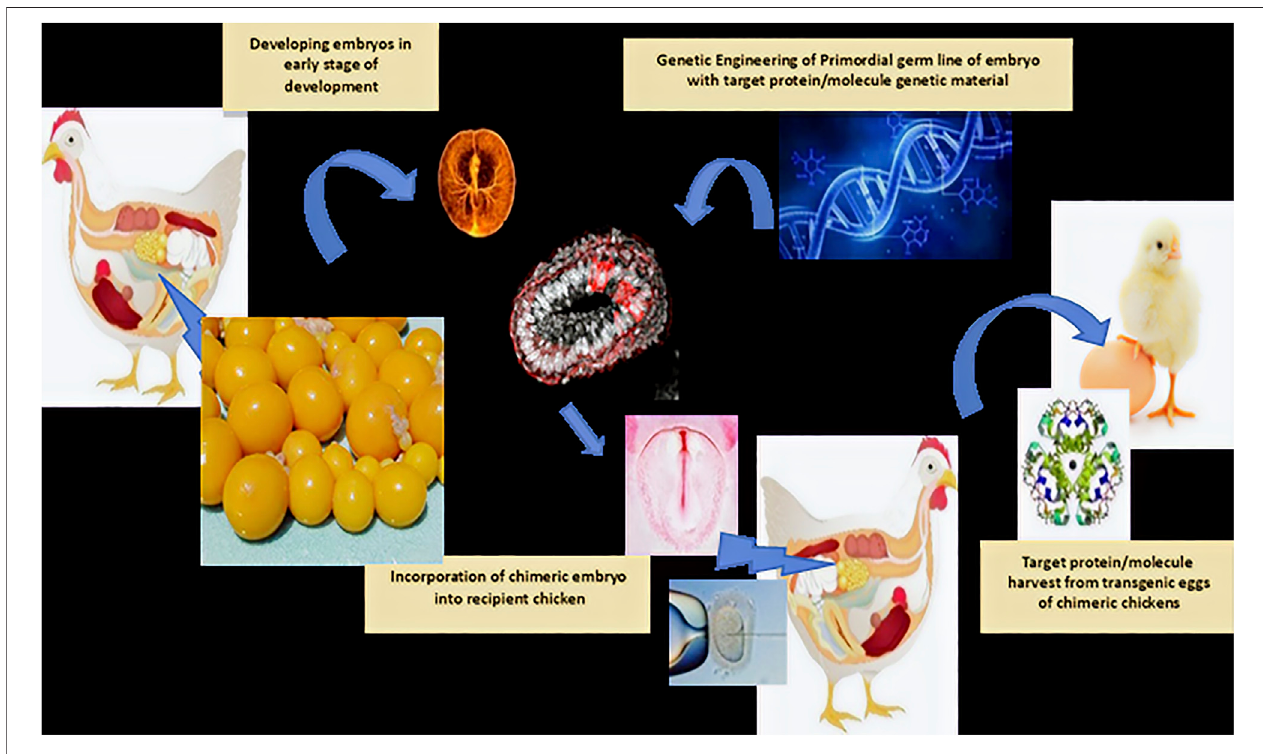
FIGURE 4 | Next-generation customized chickens through